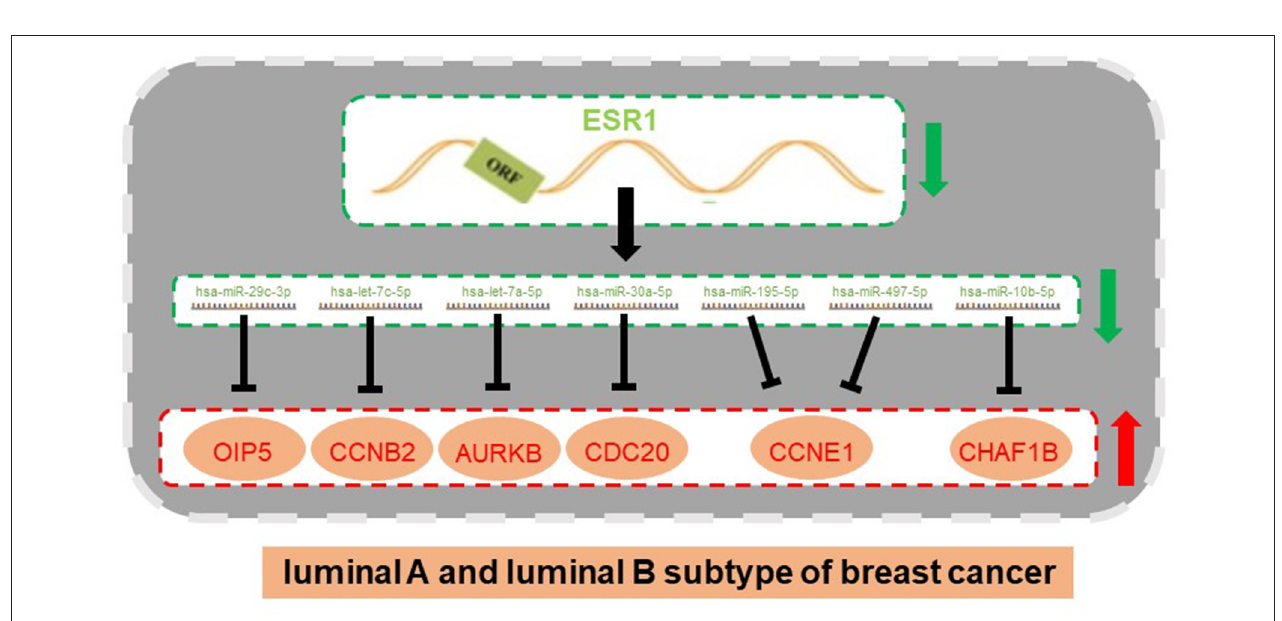
FIGURE 7 | expression. (G) The correlation analysis of CHAF1B expression and hsa-miR-10b-5p expression. (H) The correlation analysis of CCNE1 expression and hsa-miR-195-5p expression. (I) The correlation analysis of CCNE1 expression and hsa-miR-497-5p expression. “*” represented significant correlation, with P < 0.05. (J) Overexpression effect of mimics for the 7 key miRNAs at concentration of 50nM in MCF-7 cell line. (K) Overexpression effect of mimics for the 7 key miRNAs at concentration of 50nM in T47D cell line. (L) Expression change of downstream genes after increasing expression of corresponding miRNAs in MCF-7 cell line. (M) Expression change of downstream genes after increasing expression of corresponding miRNAs in T47D cell line. The data were shown as mean ± standard deviations. “*” represented significant difference, with P < 0.05. “nc” represented no statistical change.